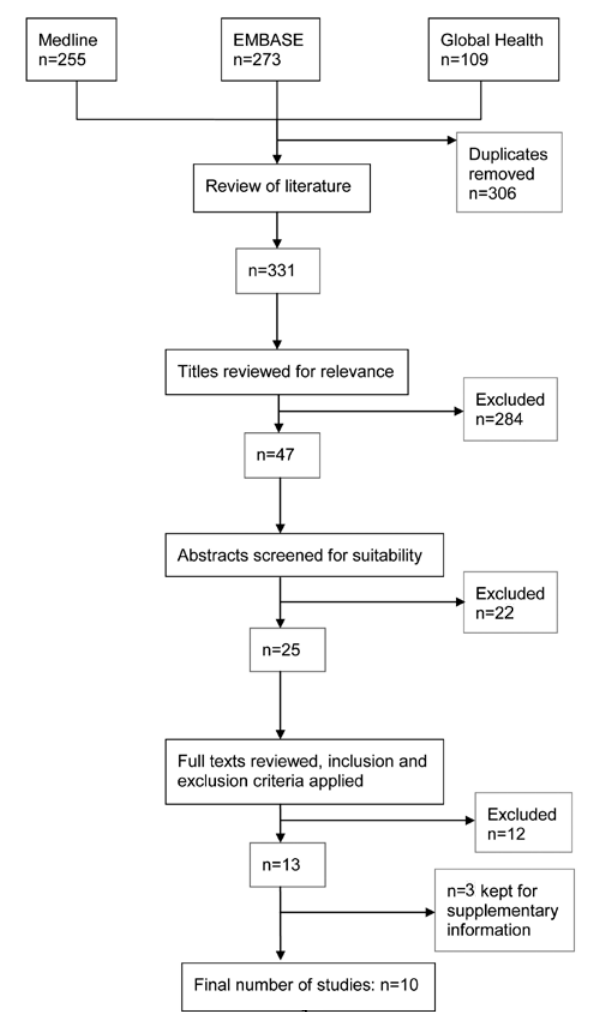
Figure 1 A summary of search strategy used to identify the studies relevant to estimating the prevalence of dementia in